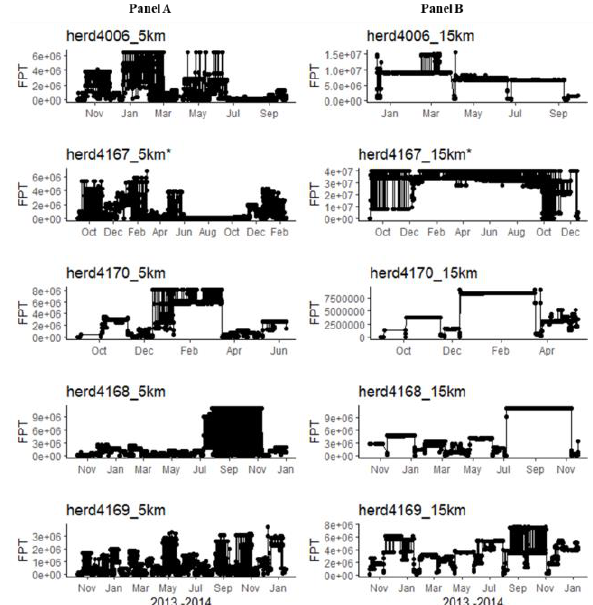
Figure 3: Space use intensity at 5 km and 15 km radius of Isiolo (herd4006, herd4167 and herd4070) and Tana River (herd4168 and herd4169) herds collared from September 2013 to 2014 except for herd4167* which was collared up to February 2015